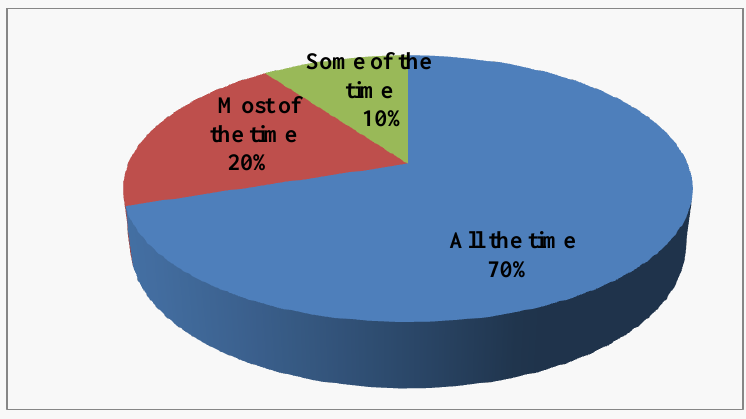
Figure1. Frequency of handwashing before preparing food.